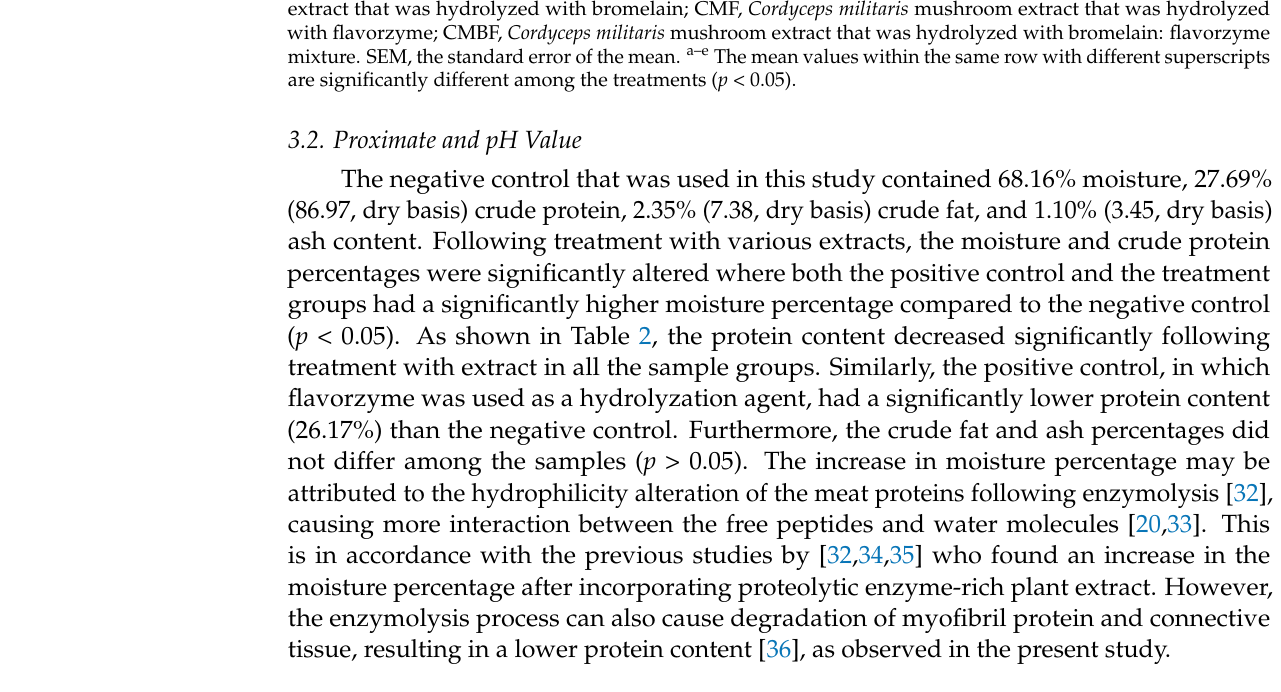
Table 2. The proximate composition of the breast meat of Korean ginseng chicken soup that was hydrolyzed with Cordyceps militaris mushroom